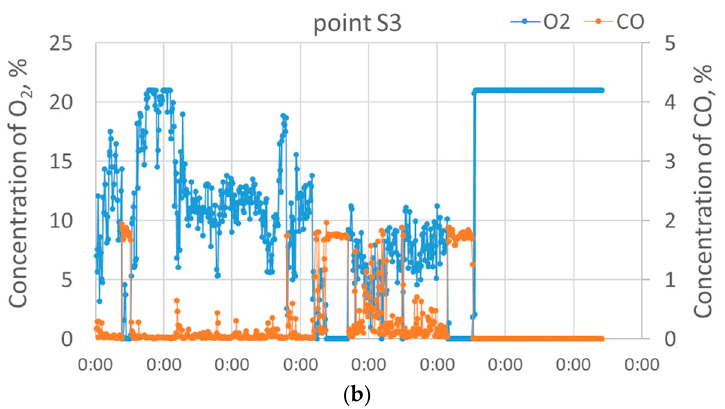
Figure 3. Examples of continuous measurements of O 2 and CO concentrations in the boundary layer at S2 and S3 measuring points (( a ) and ( b ), respectively) for one week (data recorded every 15 min).